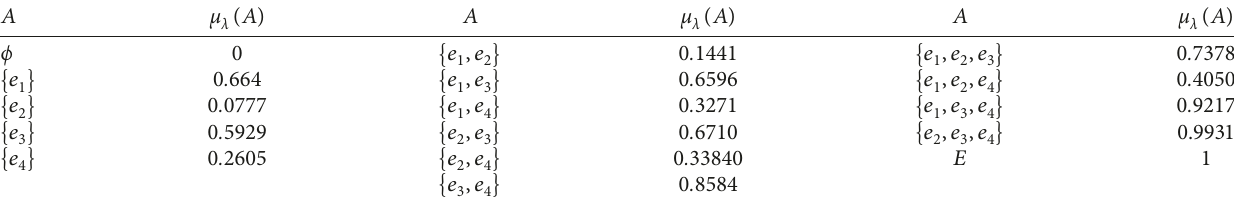
Table 2: The fuzzy measure of elements of power set of A .